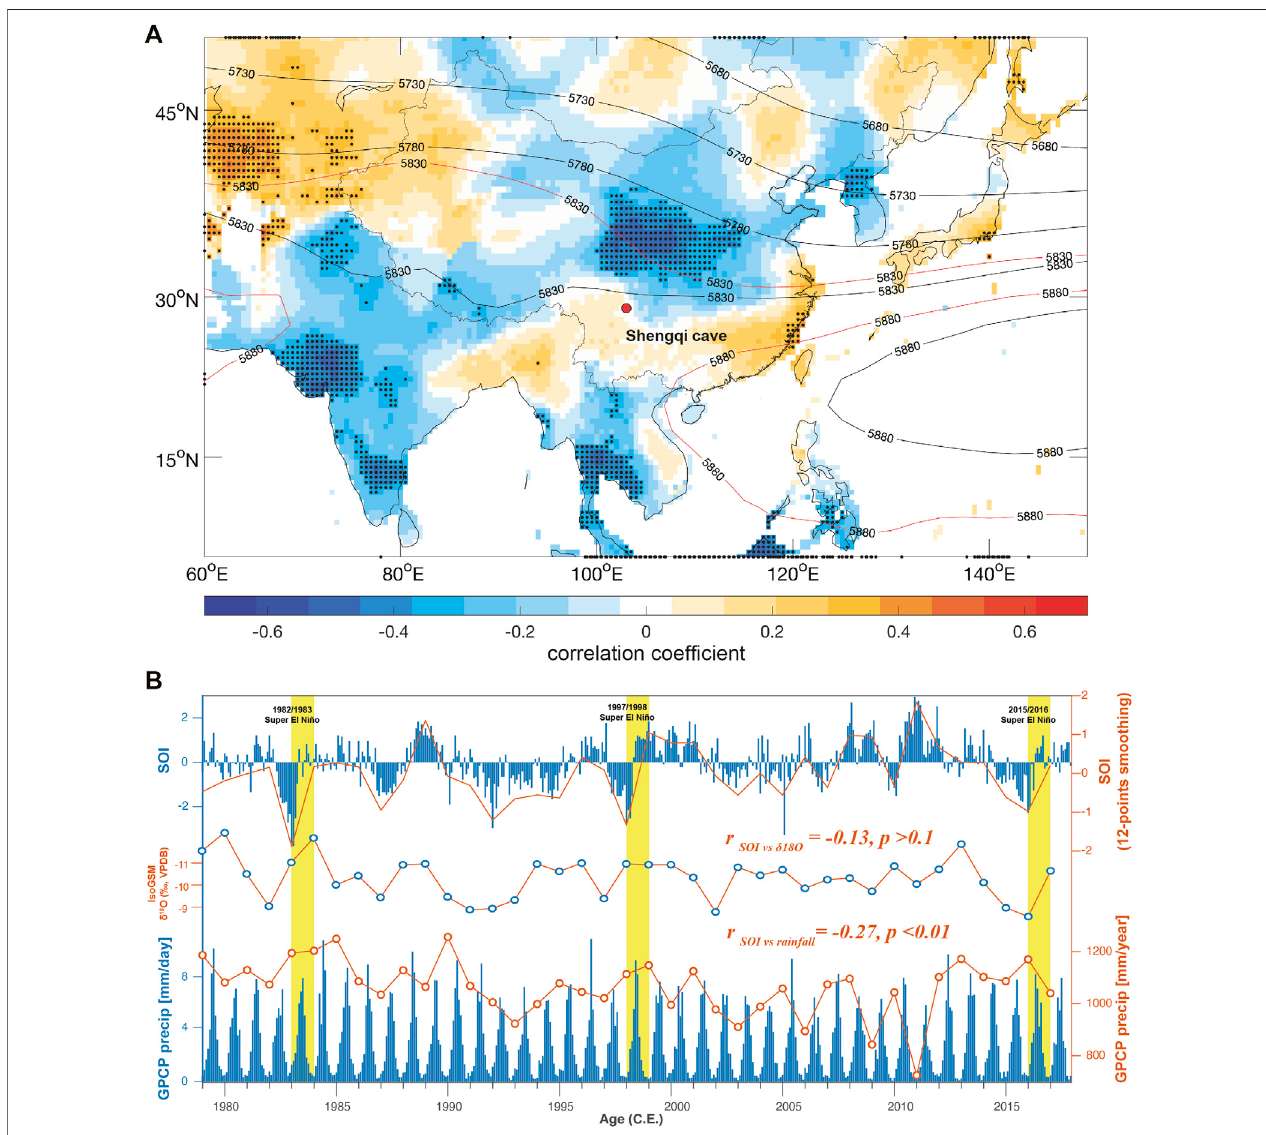
FIGURE 1 | Spatial distribution of the correlation coef fi cients between the GPCP JJAS rainfall amount and the JJAS amount-weighted δ 18 O Shenqicave(redcircule)basedontheExperimentalClimatePredictionCenter ’ sIsotope-incorporatedGlobalSpectralModel(IsoGSM)(Yoshimuraetal.,2008)between 1979and2017withJunegeopotentialheights(contoursingeopotentialmeters,gpm)at 500 hPainmeanstateof1979 – 2017(black line)and yearof2016(redline) (A) , and comparisons of the monthly amount-weighted IsoGSM δ 18 O p data with the SOI and GPCP rainfall amount records (B) . Stippling indicates signi fi cant correlation ( p < 0.1 level). Precipitation data (A) are from Climatic Research Unit (CRU) TS4.04, and the geopotential heights (gpm) are based on the monthly reanalysis data from the National Center for Environmental Prediction (NCEP) and the National Center for Atmospheric Research (NCAR). The Southern Oscillation Index (SOI)